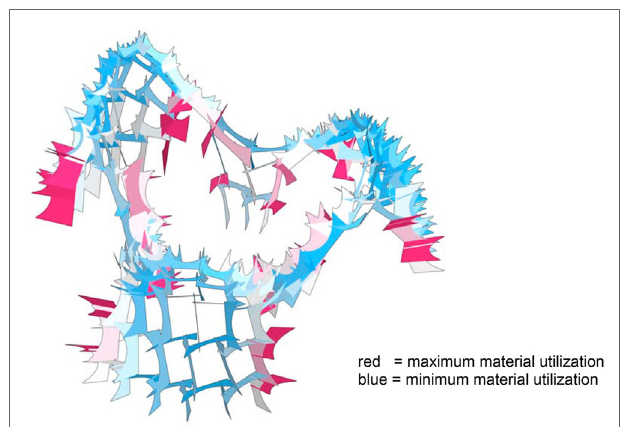
FIgURe 9 | Structural analysis in Karamba—utilization of elements (red = max, blue = min), after which the depth has been scaled in the parametric setup.